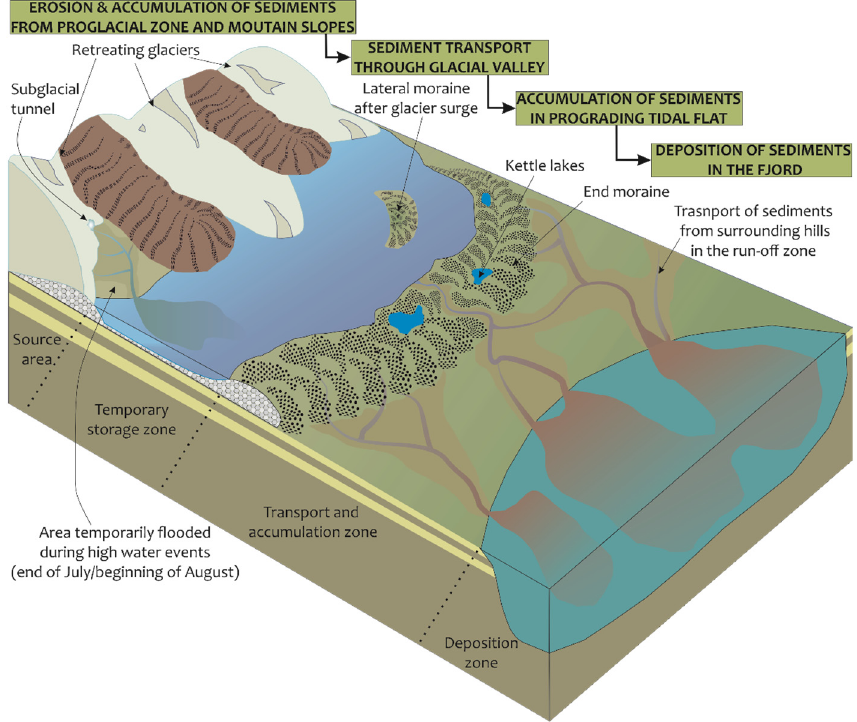
Figure 6. Conceptual model of the sediment cascade system from glacier and glacial lake to fjord environment.